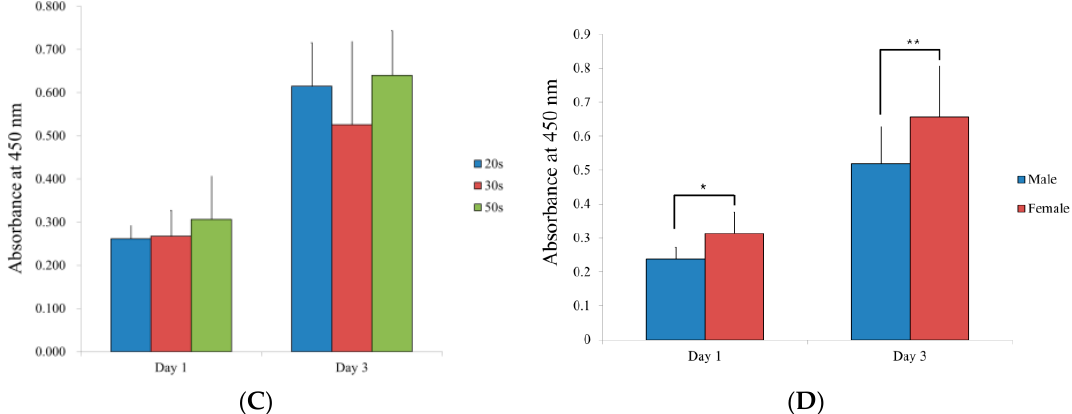
Figure 1. ( A ) Evaluation of the BMSCs’ morphology on Day 1 in osteogenic media (original mag- nification 100×). The scale bar indicates 200 μ m. ( B ) Qualitative cellular viability results under a confocal microscope on Day 4. Live images, dead images, merged images, and central images are provided. The scale bar indicates 100 μ m. ( C ) Cellular viability using CCK-8 assay on Days 1 and 3 among the age groups. ( D ) Cellular viability using a CCK-8 assay on Days 1 and 3 in males and females. * Statistically significant differences were noted when compared with the males’ results on Day 1 ( p < 0.05). ** Statistically significant differences were noted when compared with the males’ results on Day 3 ( p < 0.05).